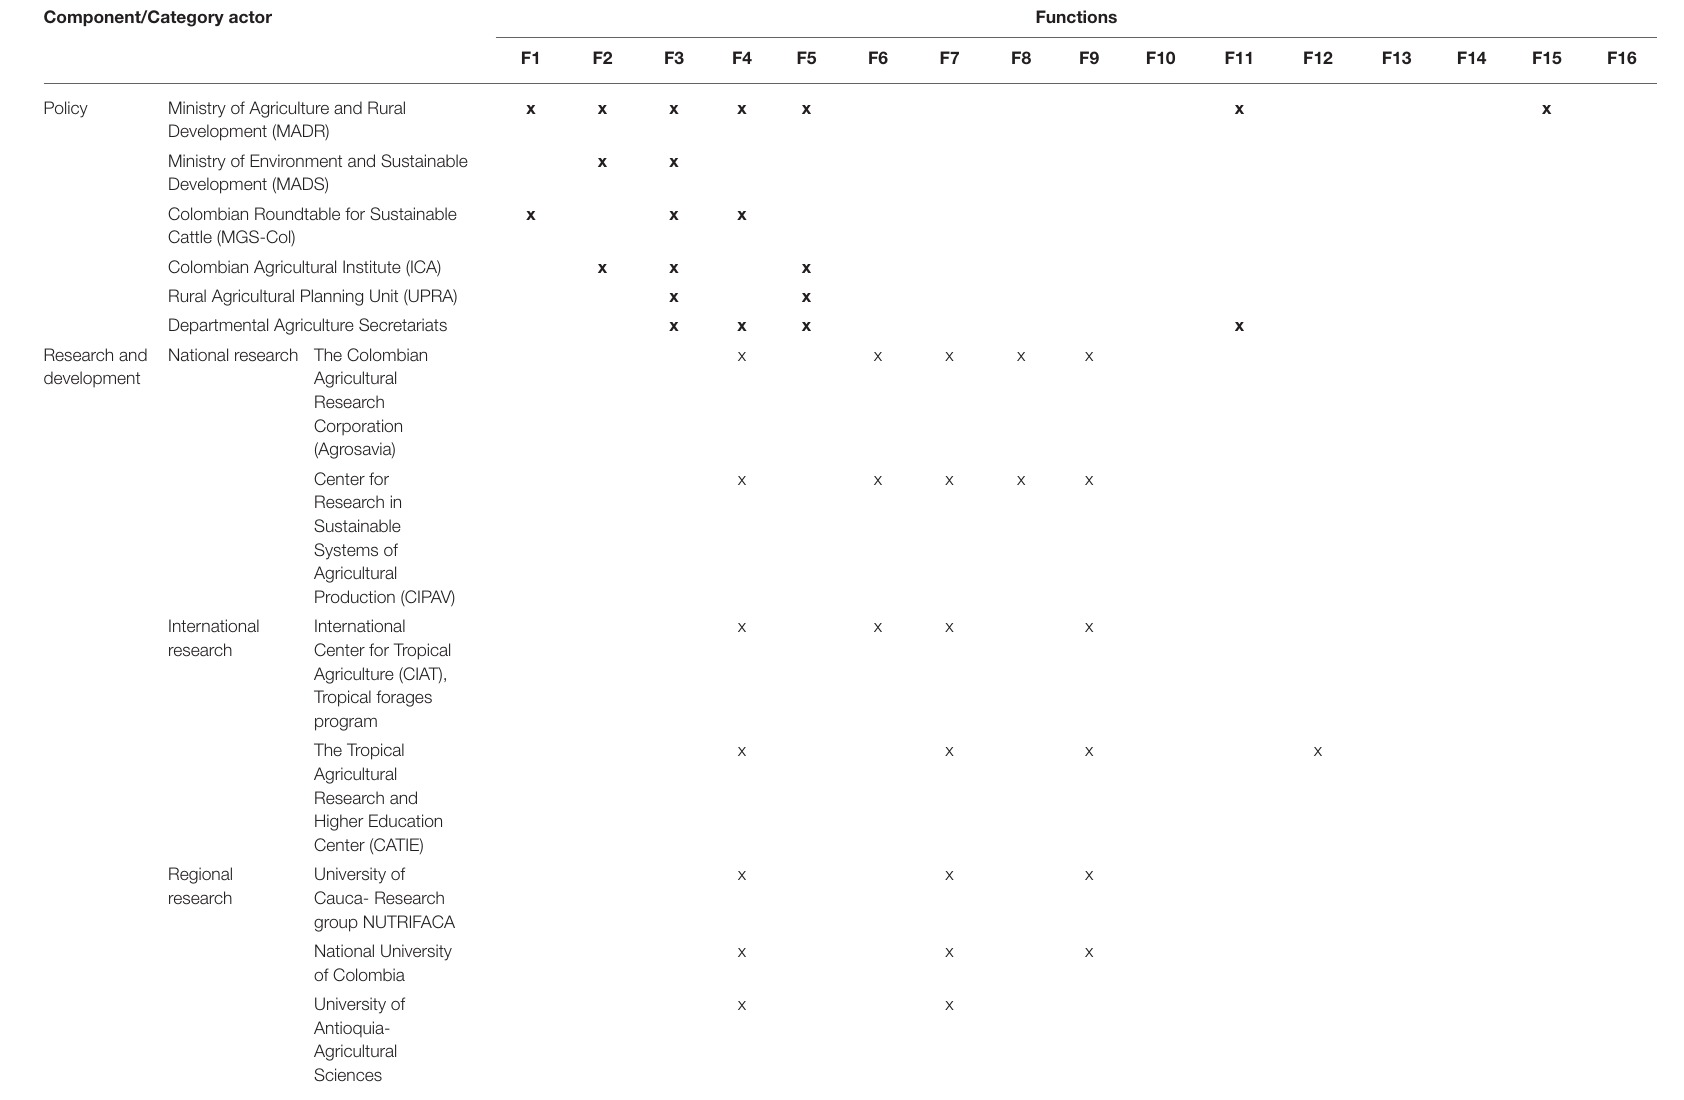
TABLE 3 | List of actors and functions of the AIS for improved forages in Colombia. Component/Category actor